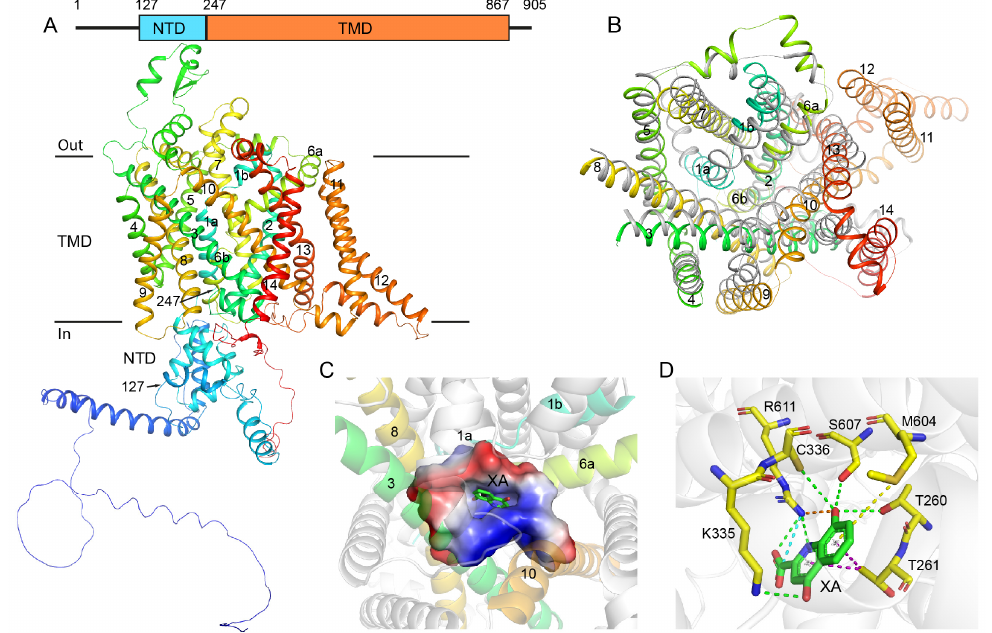
Figure 1. Putative structure of gametogenesis essential protein 1 (GEP1) and its binding model with xanthurenic acid (XA). ( A ) Cartoon represented structure of GEP1 predicted by AlphaFold2 colored in spectrum with N-terminus in blue and C-terminus in red. The number of the transmembrane helices and domain boundaries are indicated. ( B ) Structure superimposition of the transmembrane region between GEP1 (rainbow) and the human serotonin transporter (grey, PDB 7LI7). The extracellular and intracellular loops are hidden for the purposes of clarity. ( C ) The cartoon representation of XA docked in the ligand-binding pocket of GEP1, the binding pocket is represented as surface. ( D ) Interactions between ligand XA and protein GEP1, with XA in green sticks and residues in yellow sticks. Dashed lines indicate the interactions between the ligand and the residues of the receptor in green: hydrogen bond; yellow: pi-sulfur; purple: pi-sigma; orange: salt bridge; cyan: attractive charge.